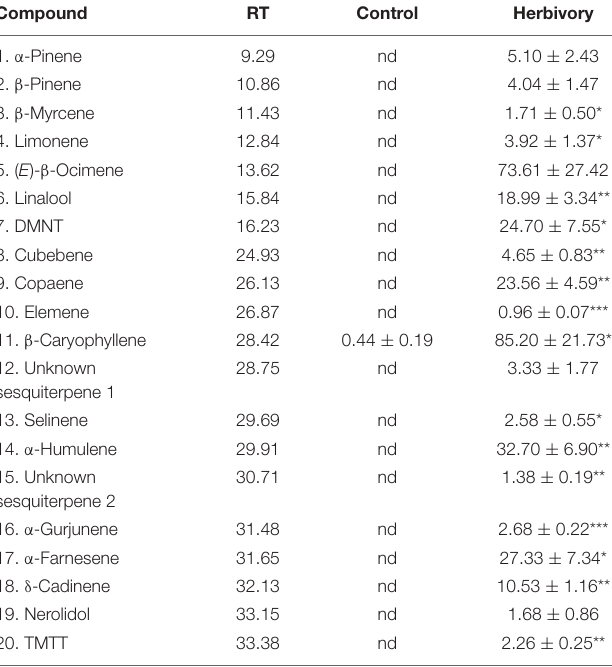
Numbered compounds correspond to those in Figure 6 . Data were tested to evaluate differences using Student’s t-test (*P <